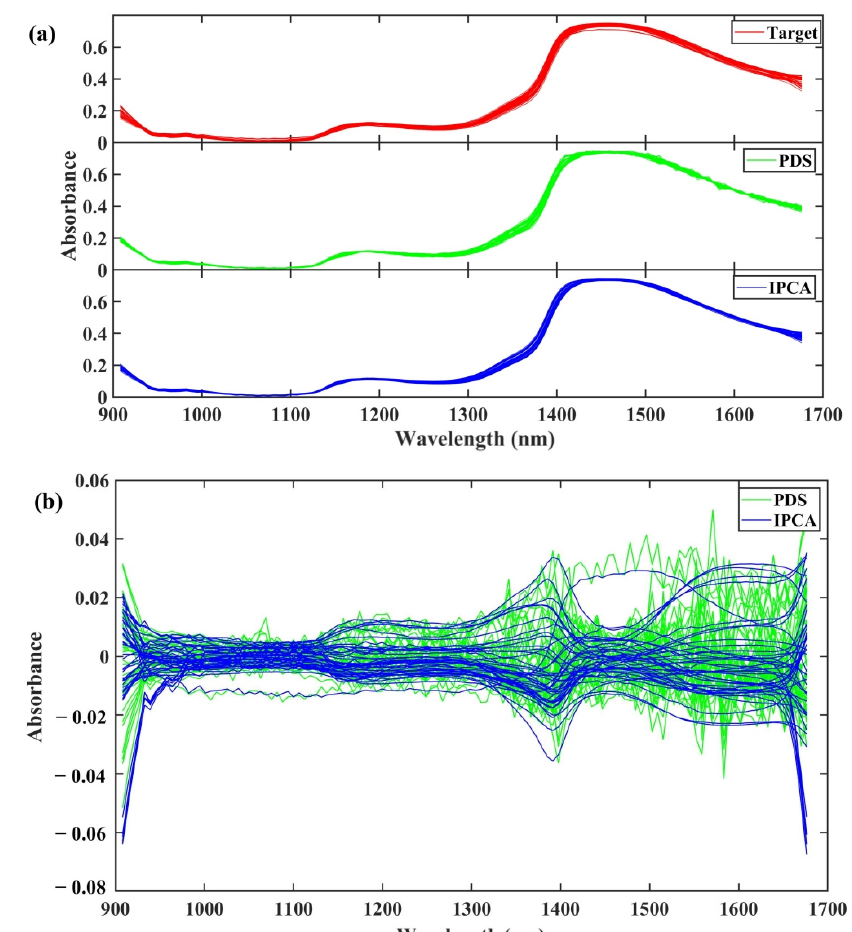
Figure 7. ( a ) Target (red) of transferred source spectra in dataset 3 with PDS (green) and IPCA (blue). ( b ) Different spectra obtained by subtracting original and transferred spectra in validation set with PDS (green) and IPCA (blue).